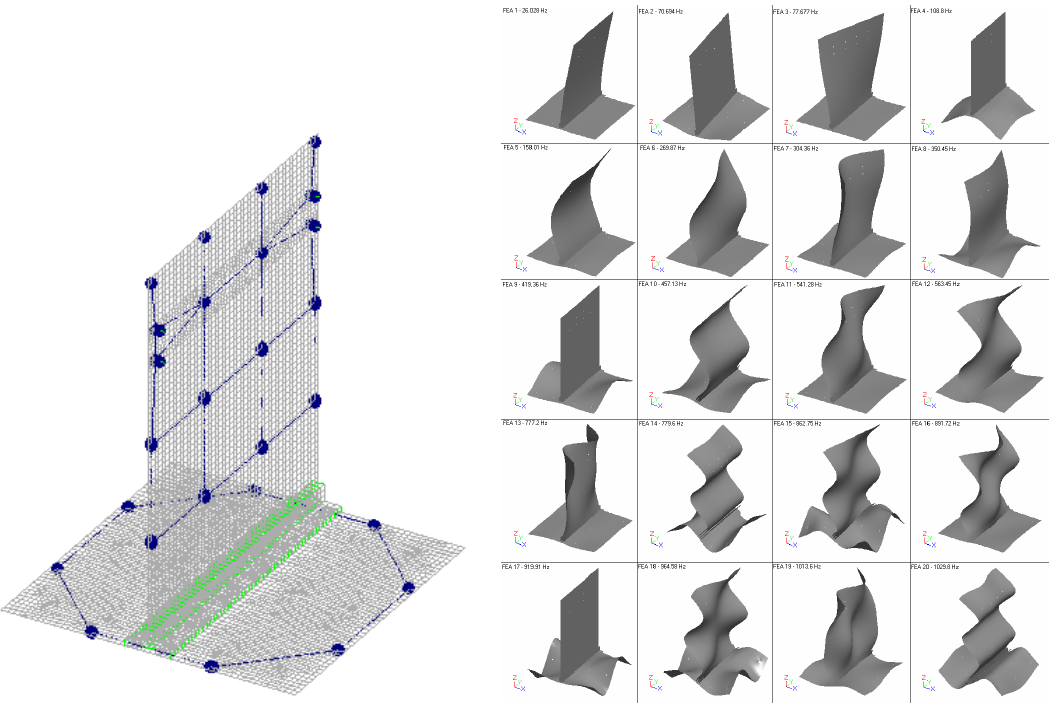
Fig. C-2. Upright finite element model with first 20 mode